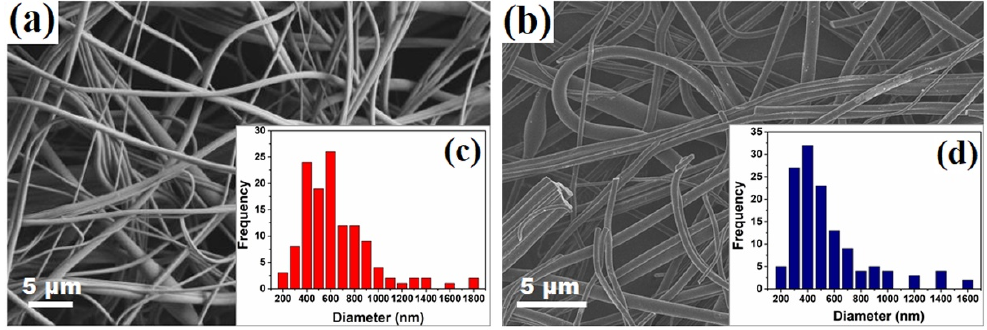
Figure 3. SEM images of ( a ) nonwoven Poly(vinyl alcohol) (PVA) nanofibers mat and ( b ) nonwoven carbon nanofibers (CNF) mat without MWCNT. Histograms representing fiber diameter distributions are shown as insets for both systems ( c ) and ( d ).